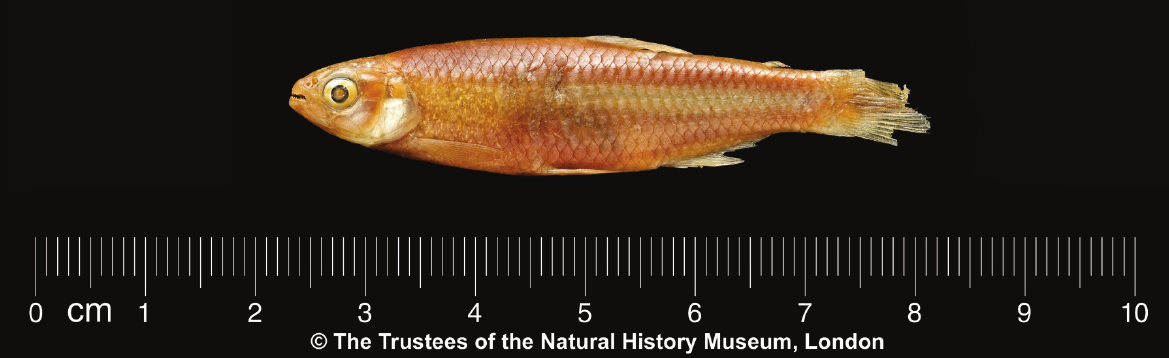
Table 1. Meristic data of Chirodon alburnus and Aphyocharax pusillus.